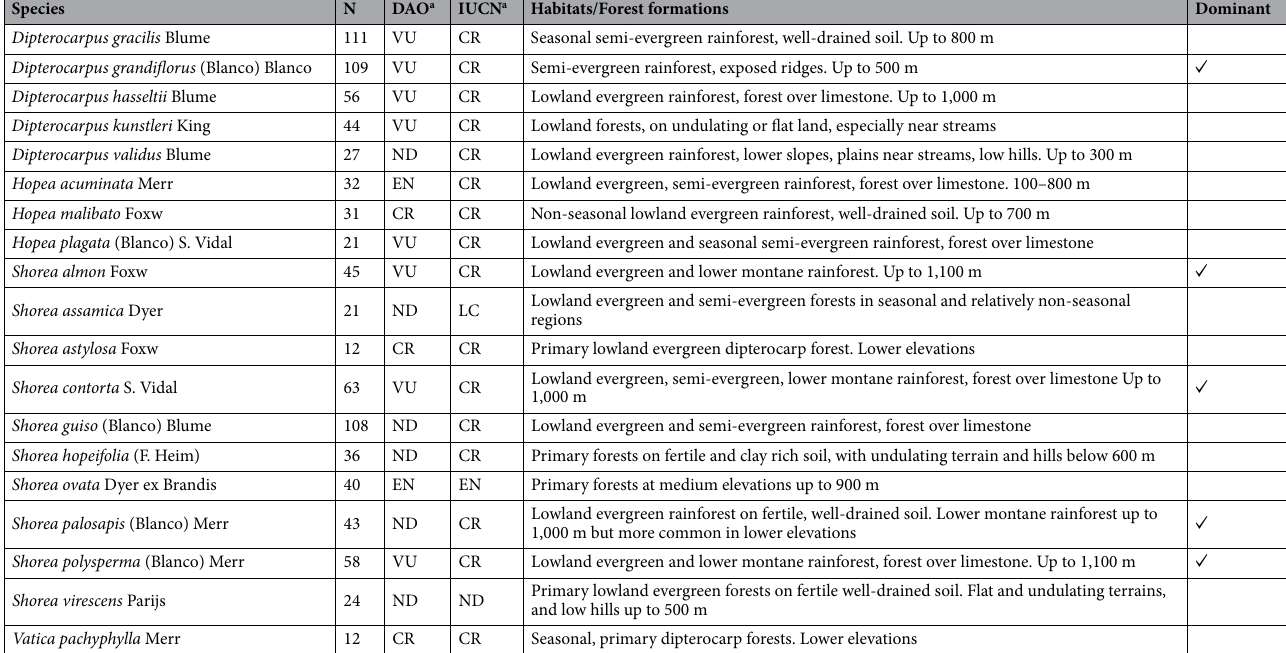
Table 1. The final 19 Dipterocarpaceae species in the Philippines included in this study showing the number of occurrences remaining after thinning (N), their threat status based on DAO 2017–11 and IUCN 2019 (DAO 51 ; IUCN 52 ), their habitats (Fernando et al. 26 ; Pelser et al. 56 ), and if they are a dominant species